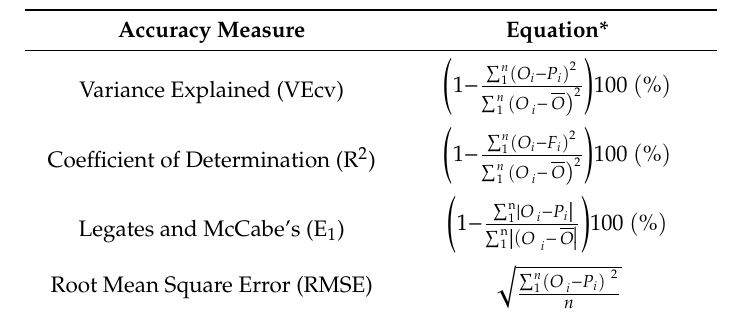
Table 3. The names and equations of accuracy measures used in this